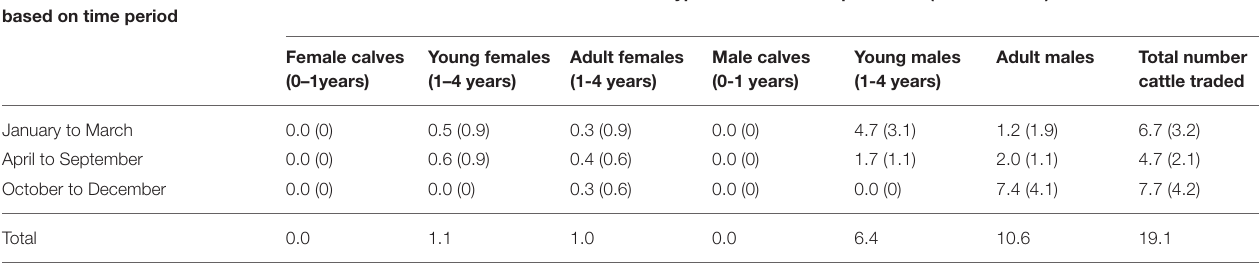
Annual number and type of cattle traded per trader (mean and